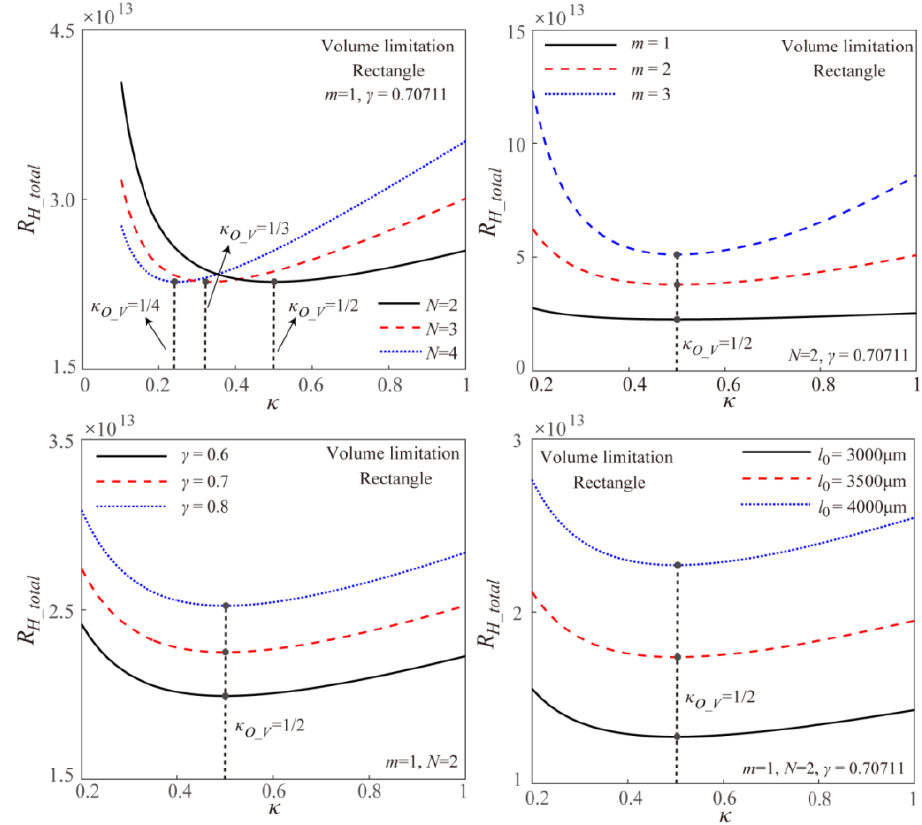
Figure 5. Effects of the branching number N , the branching level m , the channel length ratio γ, and the channel length l 0 at the original branching level on the EOF fluidic resistance in the symmetric fractal rectangular microchannel network under volume limitation.